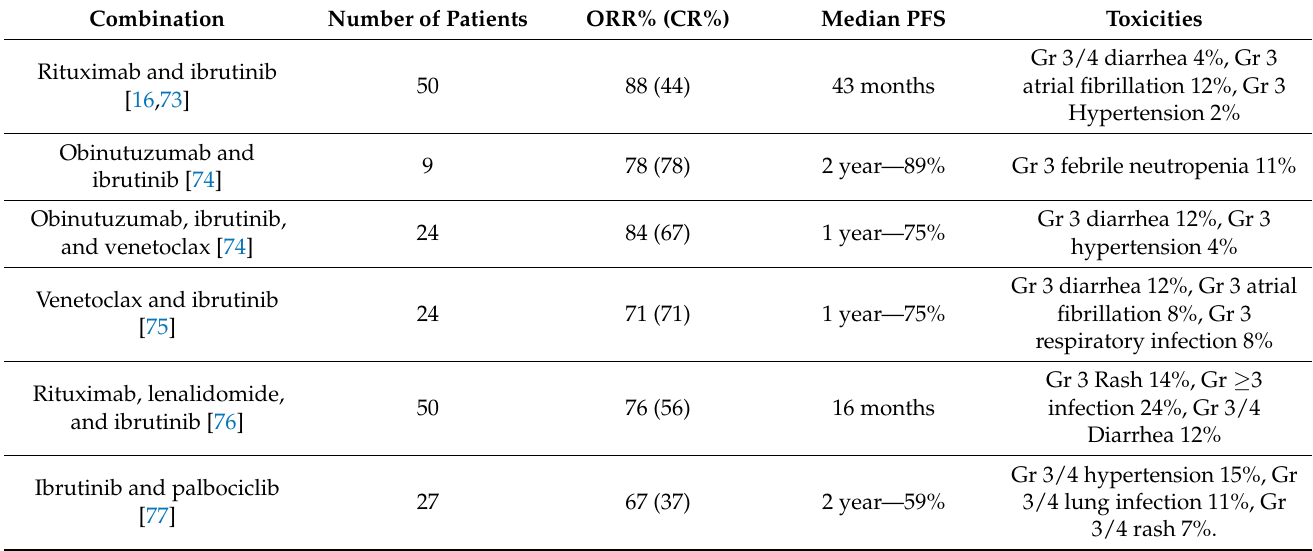
Table 1. Summary of Published Combination Studies in Relapsed Mantle Cell